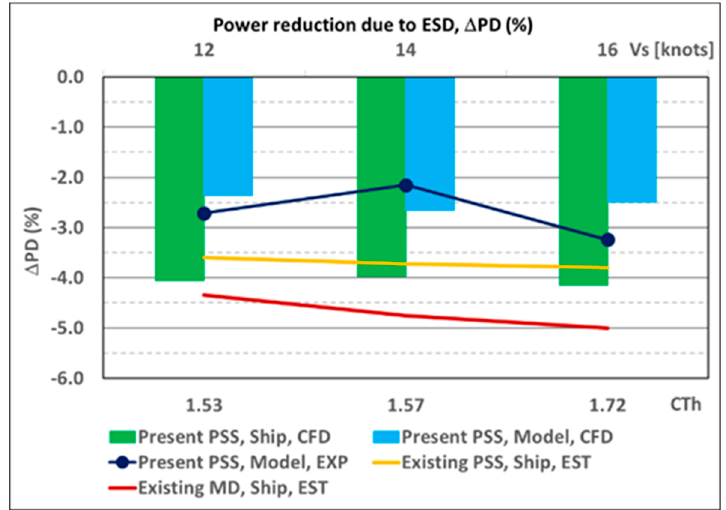
Figure 25. Comparison of power savings due to ESD installation.